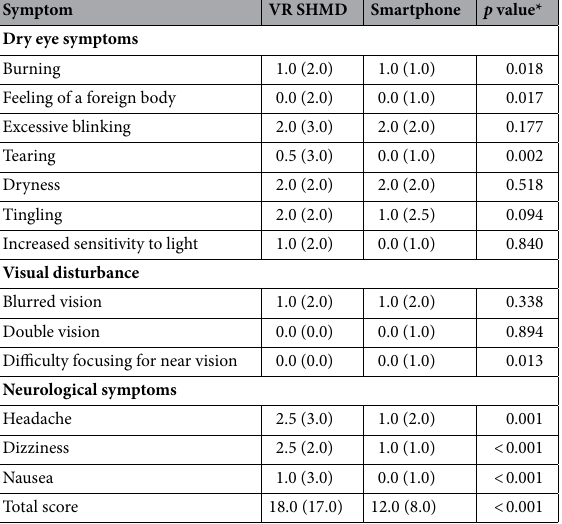
Table 1. Comparison of subjective symptoms after playing games on a virtual reality smartphone-based head- mounted display (VR SHMD) or smartphone. Data presented as median (interquartile range). *Wilcoxon- signed rank test and adjusted using the Benjamini–Hochberg procedure.